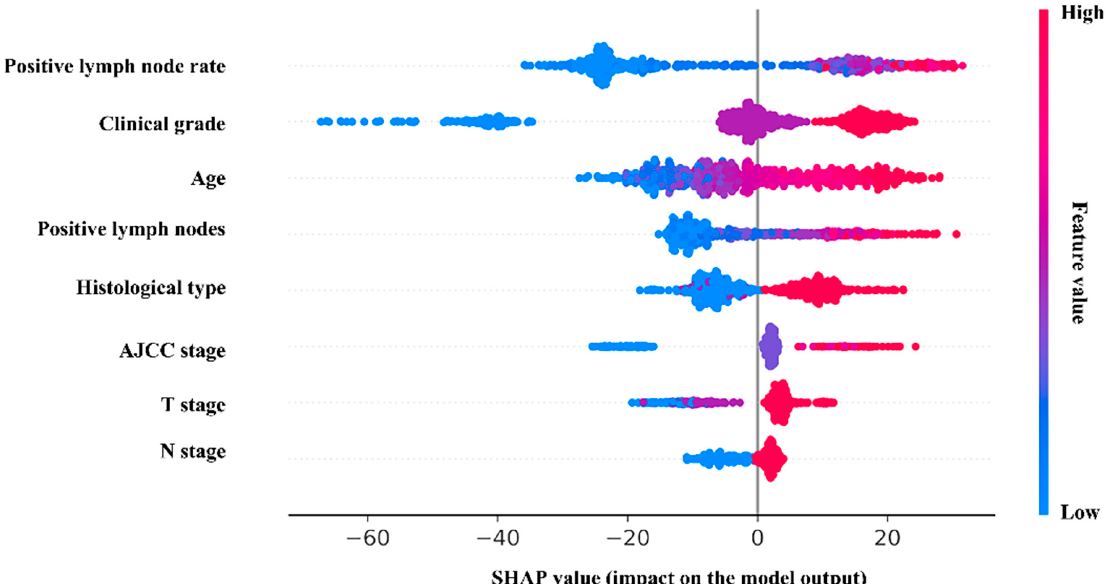
Figure 4. The SHAP plot of the RSF model. In the SHAP plot, the length of the horizontal axis where